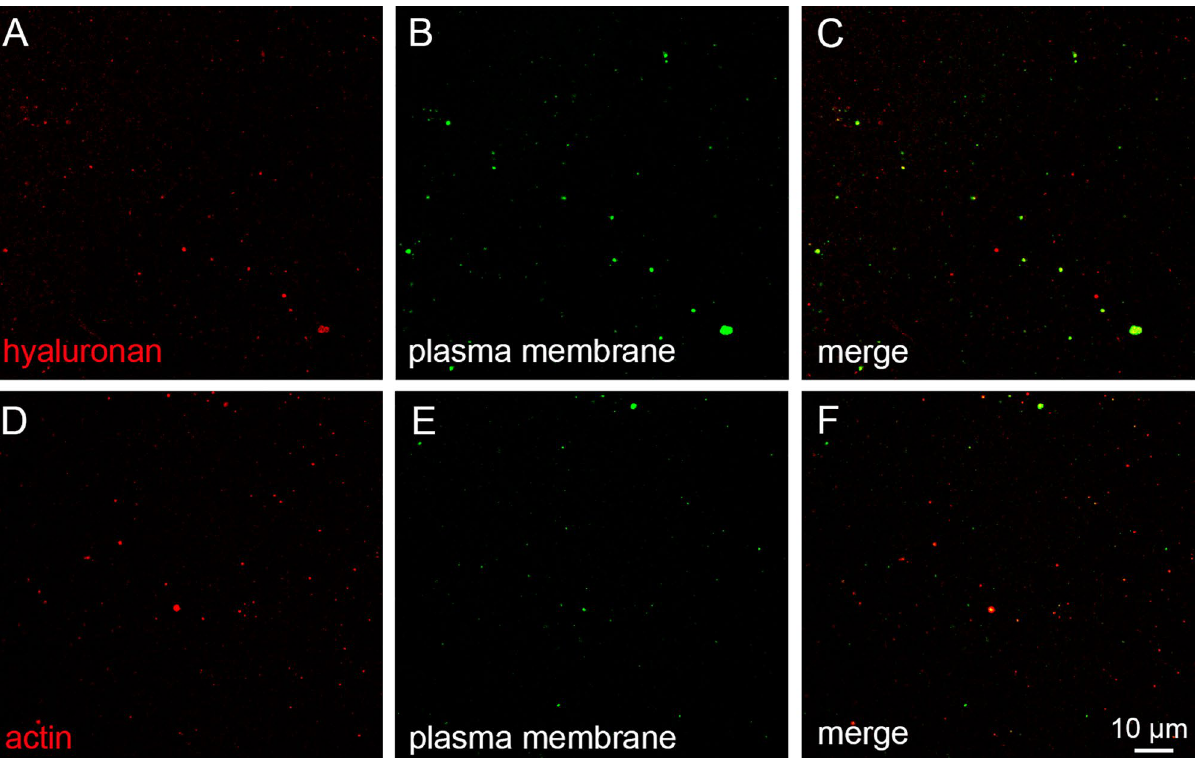
Figure 3. Equine synovial fluid (SF) stained with CellMask Deep Red plasma membrane stain, Alexa Fluor 568-labeled hyaluronan binding complex (HABC), and Alexa Fluor 594-labeled phalloidin. An unprocessed SF sample stained with HABC (pseudocolored red) and CellMask (pseudocolored green) in panels ( A and B ), an ultracentrifuged SF sample stained with phalloidin (pseudocolored red) and CellMask (pseudocolored green) in panels ( D and E ), and merged images in panels ( C and F ) depicting the co-localization of the